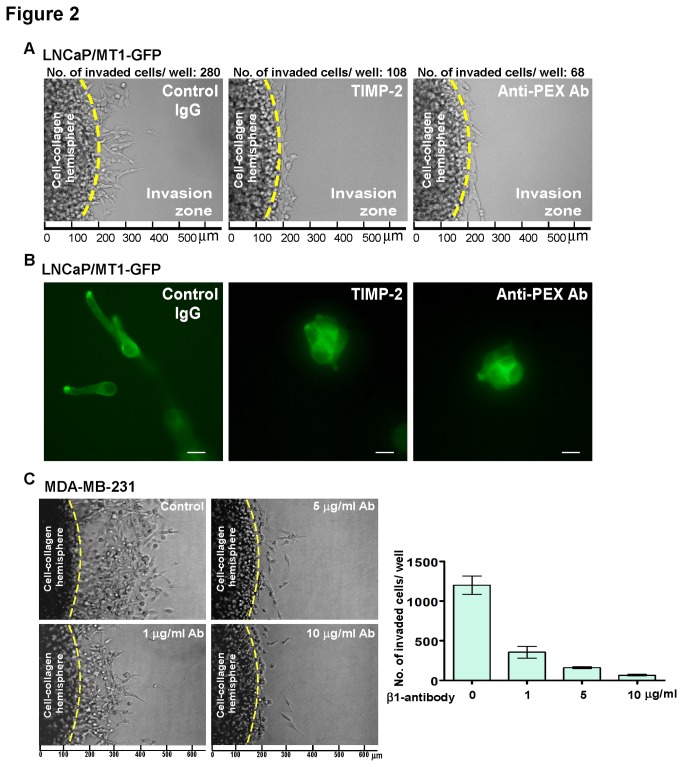
Evaluation of novel 3-D invasion assay.A & B) Comparison of the novel 3-D invasion assay and 3-D cell scattering assay: The effect of control IgG (Rabbit, 10 μg/ml), tissue inhibitor of metalloproteinase-2 (TIMP-2) (10 nM), or anti-MT1-MMP-hemopexin domain antibody (Anti-PEX Ab) (10 μg/ml) on MT1-GFP-induced LNCaP cell invasion was evaluated via the 3-D invasion assay (A) and 3-D cell scattering assay (B). An invasive growth pattern was photographed on day 1 (A) and day 6 (B) respectively. TIMP-2 and the anti-PEX Ab decreased the cell invasive/scattering ability of MT1-GFP expressing cells. Scale bar = 20 μm. C) Dose-dependent inhibition of human breast cancer MDA-MB-231 cells by anti-β1 integrin antibody: MDA-MB-231 cell invasion was examined using the 3-D invasion assay in the presence of the anti-β1 integrin antibody at different concentrations vs. control IgG. Invaded cells were microscopically examined (left panel) and counted (right panel). Bars represent the mean + SD.